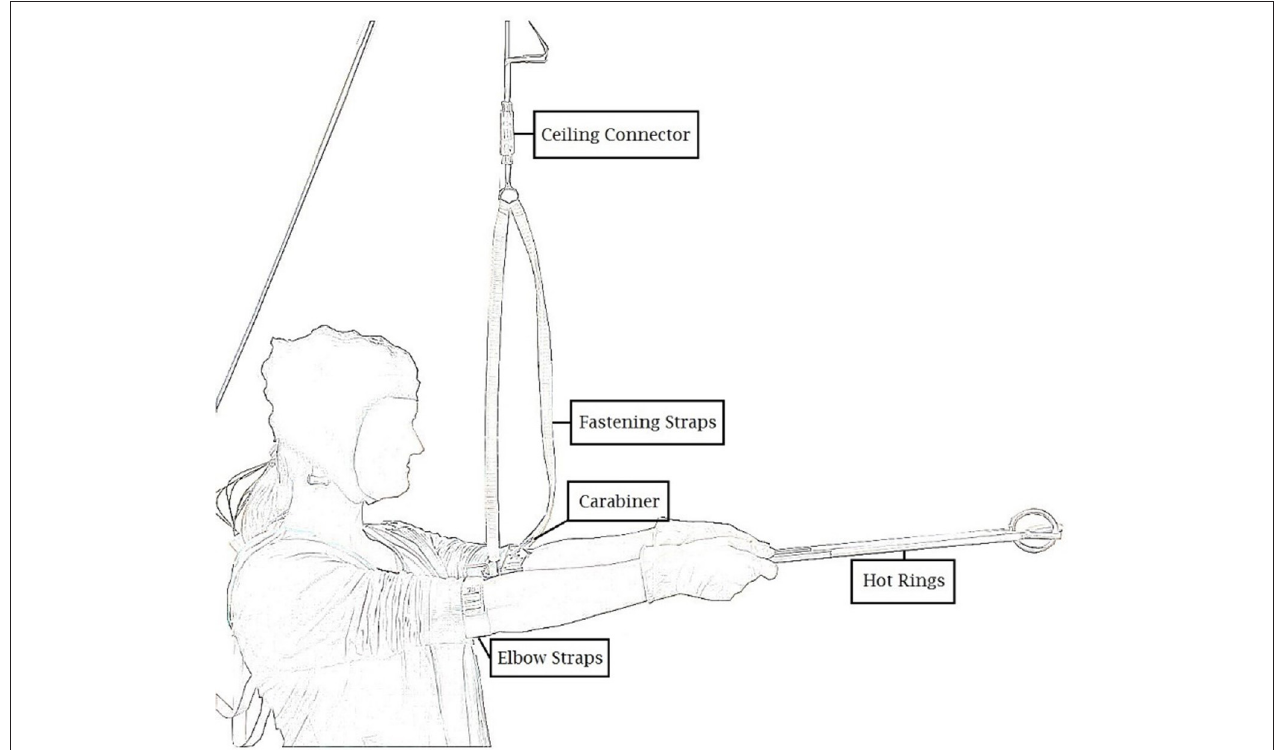
FIGURE 1 | Schematic illustration of the static muscular endurance